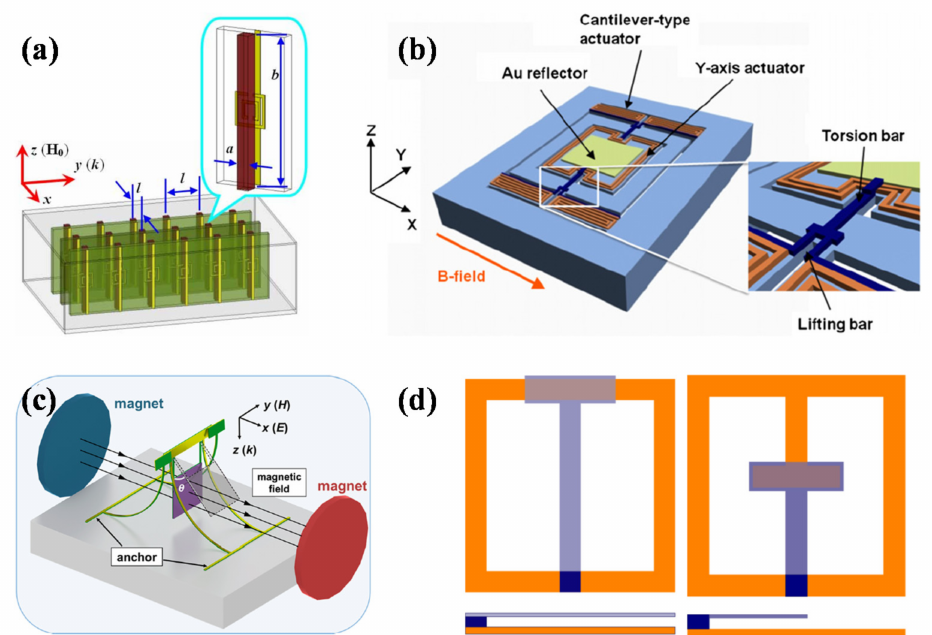
Figure 6. EMA-based tuning methods of metamaterial: ( a ) schematic of the magnetically tunable left-handed metamaterial (LHM) composed of SRRs/wires array and introducing yttrium iron garnet (YIG) rods in rectangular waveguide [91]; ( b ) schematic of the three-axis EMA-based micromirror for fine alignment among optical devices [92]; ( c ) schematic of active out-of-plane metadevice by driving a magnetic field [51]; ( d ) schematics of an eSRR modified to incorporate a parallel plate capacitor with a flexing cantilever